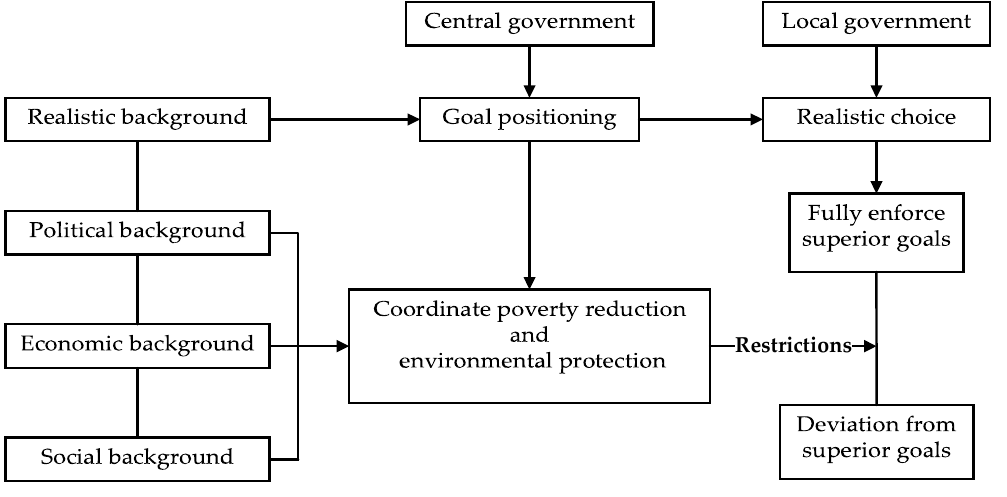
Figure 1. Theoretical analysis framework.